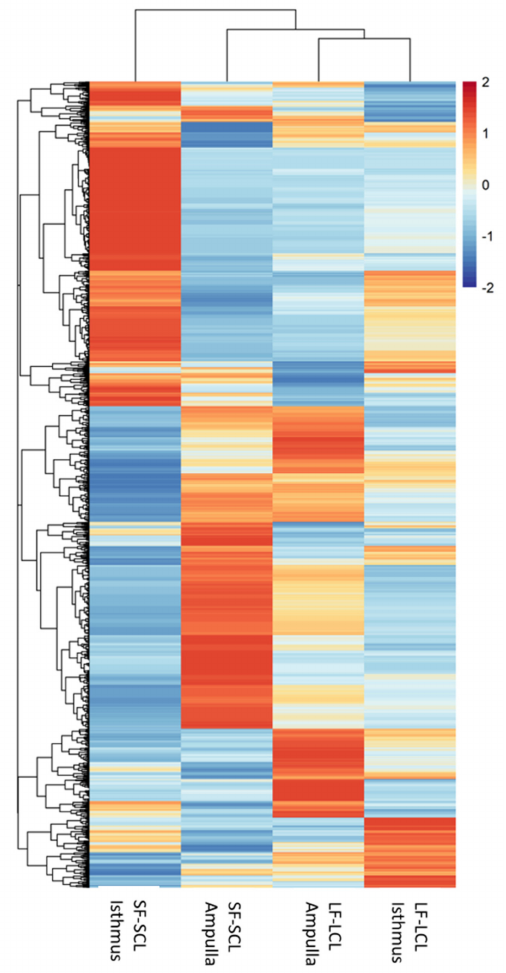
Figure 5. Clustering analysis of miRNA-mRNA interactome. Heat map constructed by clustering miRNA-mRNA interaction in ampulla and isthmus of the LF-LCL and SF-SCL groups ( n = 6). Each row represents the adjusted gene expression of a mRNA predicted to be modulated by a